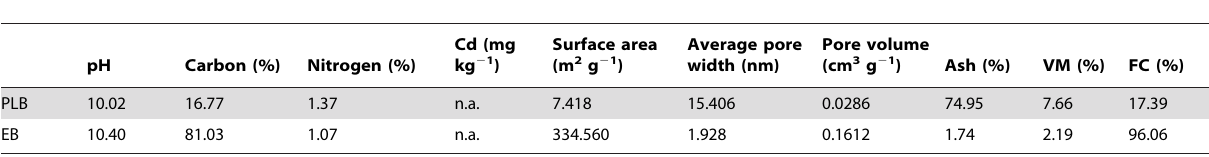
Table 1. General characteristics of the biochars used in the experiment.